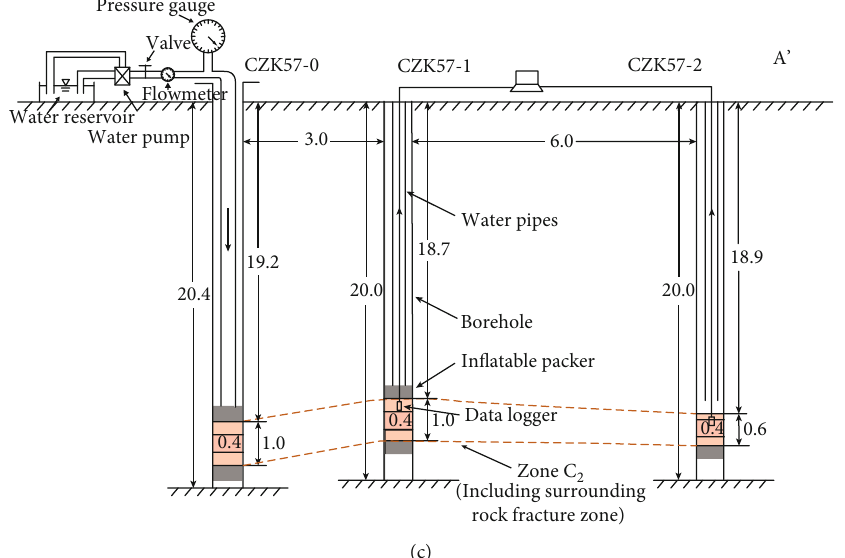
Figure 4: The distribution and sectional view of the testing site of borehole CZK57: (a) photo of the test site, (b) the distribution of three boreholes, and (c) the pro fi le of the three boreholes (all dimensions are in units of m).